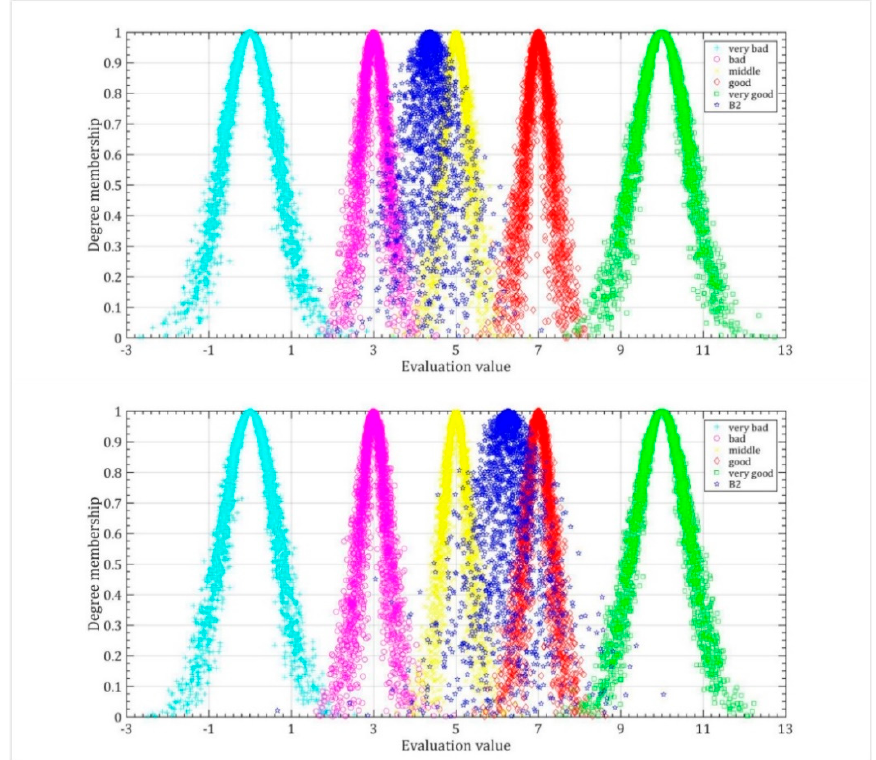
Figure 11. Cloud image of welfare evaluation grades of social security of land-lost farmers' households under different livelihood assets .